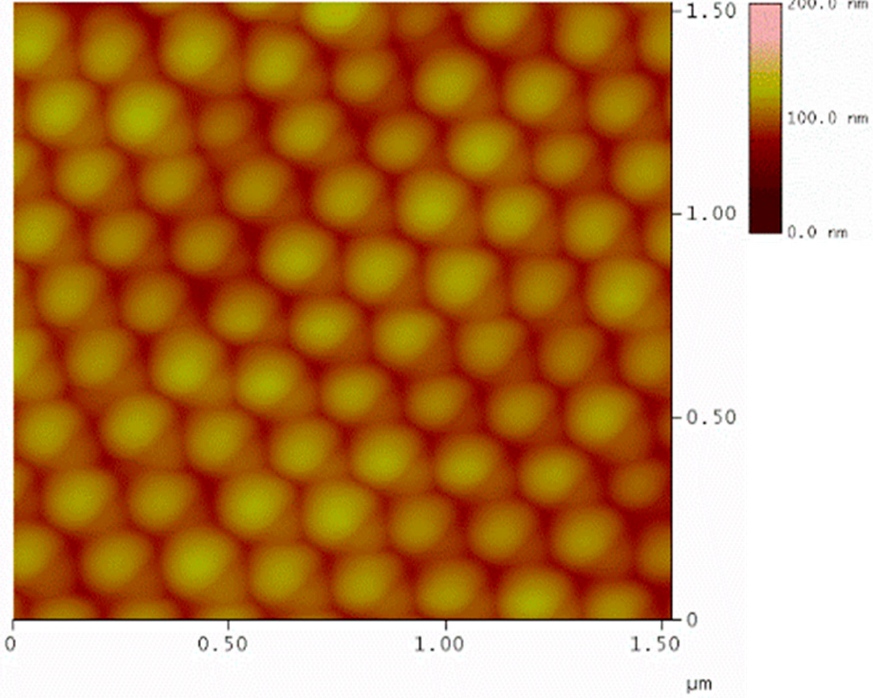
Figure 10. Surface topography obtained by atomic force microscopy (AFM) microscopy with height analysis. The Polystyrene nanosphere diameter is in excellent agreement with the nominal. Table 1. Spin coating routine summary .